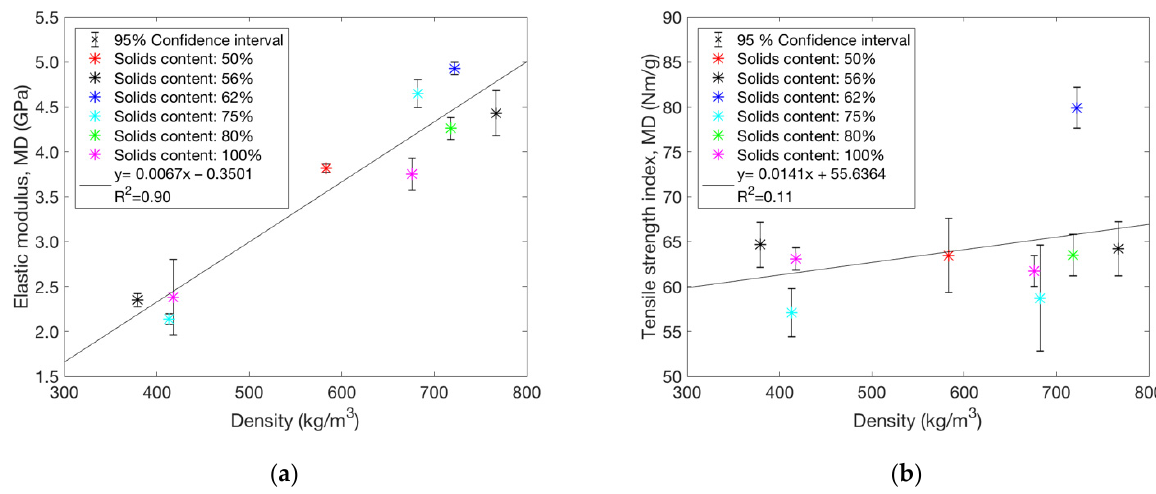
Figure 9. ( a ) Elastic modulus (MD) of hot-pressed sheets with and without nip pressure follows the density as expected. ( b ) Correlation between tensile strength index (MD) and density is still rather weak. The solids contents prior to pressing are indicated in the figures. Note the highest value, which appears like an outlier here, comes from the same measurement as the corresponding point in ( a ). The points represent an average of 10 data points and their 95% confidence intervals.